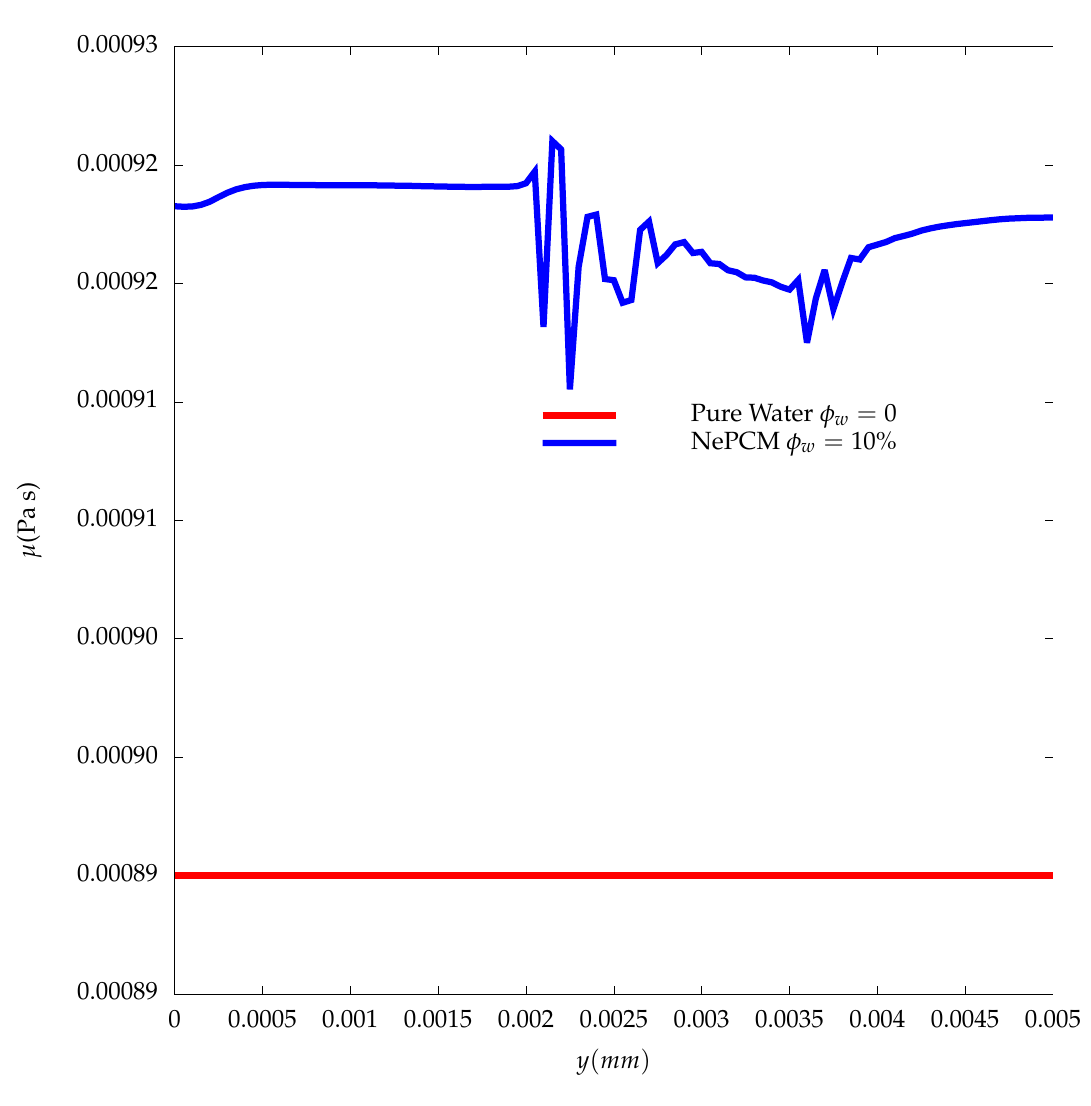
Figure 12. Compression between the viscosity evolution along vertical line located at x = 0.005 mm, and a long the y -axis for the case of φ w = 0, and